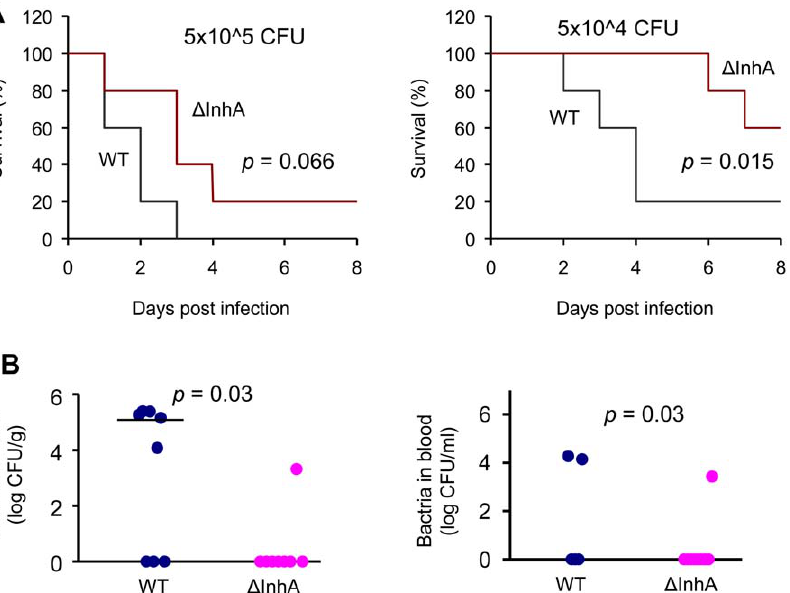
Figure 6. InhA contributes to virulence of B.anthracis infection in mice. Animals were injected intravenously into the tail vein with indicated CFU of the early-log-phase vegetative bacteria of Ames 35 (WT) and D inhA strains, correspondingly. Mice were monitored twice daily for mortality and survival. (A) Kaplan–Meier survival curve ( n =5 in both groups). Control mice ( n =3) injected intravenously with PBS did not die (data not shown). Data were analyzed using the log-rank test. (B) Bacterial load in brains (left panel, n =8) and blood ( n =5, right panel) in mice challenged with 5 6 10 5 CFU as in (A) at 48 h post challenge. Bar in (B) represents median bacterial CFU.